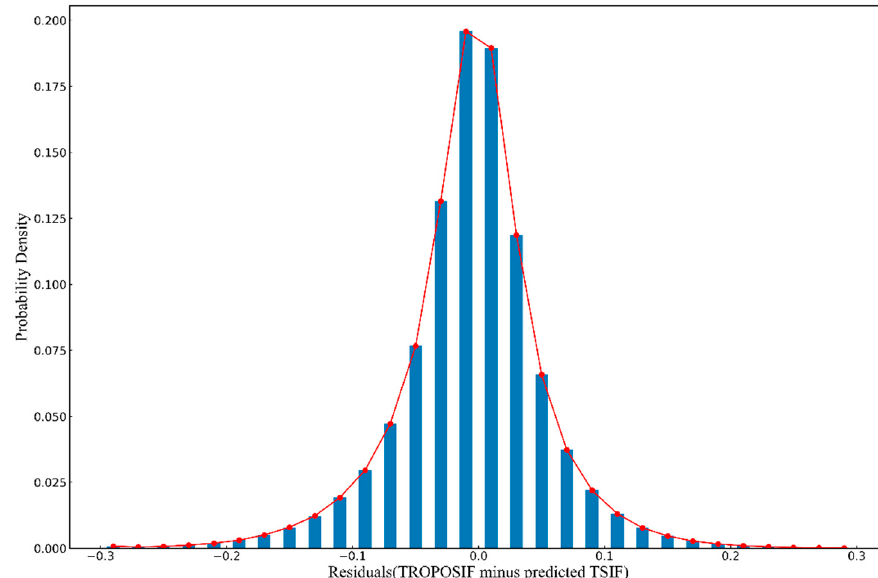
Figure 3. The probability distribution of residuals (TROPOSIF minus predicted TSIF).